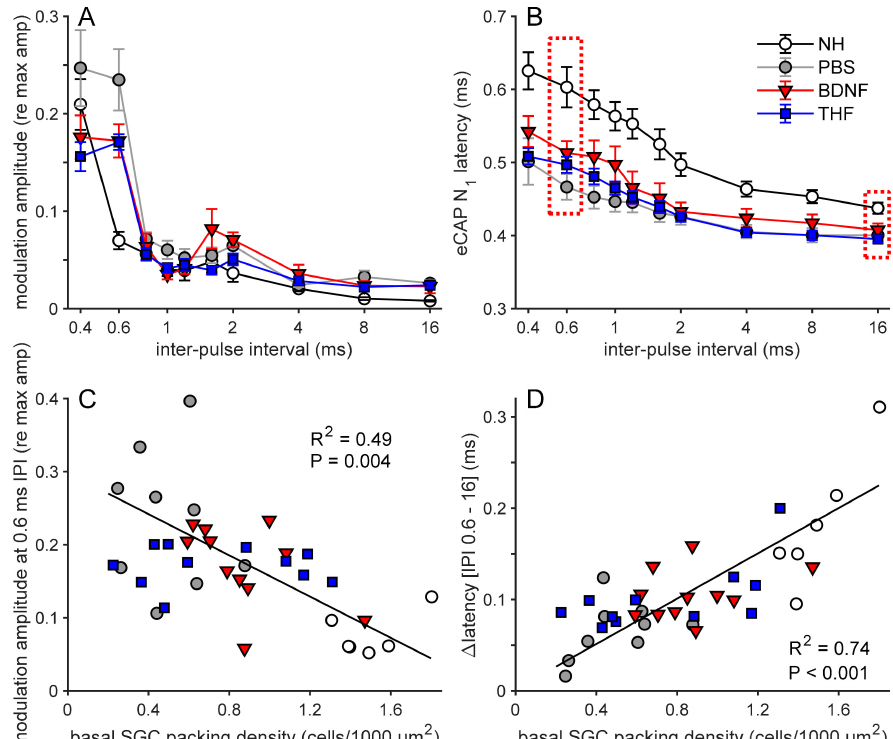
Figure 9. Pulse train response parameters. ( A ) Group means of normalized amplitude modulation determined for the last 6 pulses of a 10–pulse train as a function of IPI. ( B ) Group means of eCAP N 1 latency averaged over the last 6 pulses of the 10–pulse train as a function of IPI. ( C ) Amplitude modulation for 0.6-ms IPI for individual animals as a function of basal SGC packing density. Regression line and parameters are based on untreated (NH and 6WD) animals only. ( D ) The di ff erence in N 1 latency between 0.6-ms IPI and 16-ms IPI (dashed boxes in ( B ) as function of basal spiral ganglion cell packing density. Regression line and parameters are based on untreated (NH and 6WD) animals only. NH, n = 9 ( n = 6 in C , D ); PBS, n = 9; BDNF, n = 11; THF, n = 11 animals. IPI, inter-pulse interval. Error bars represent